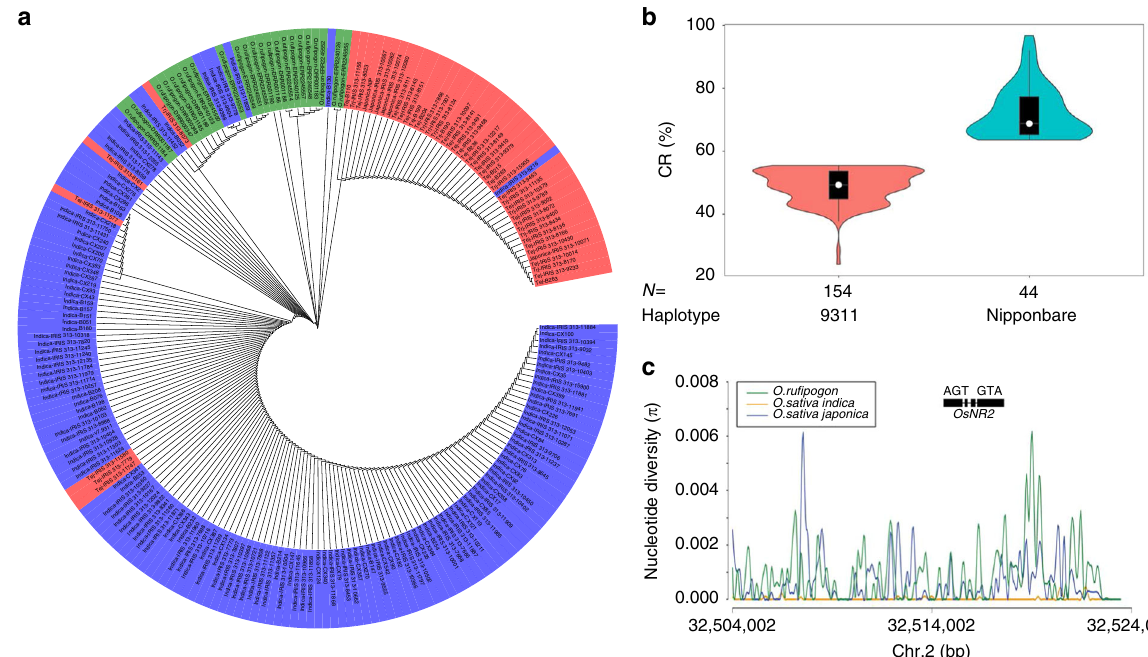
Fig. 3 Phylogenetic and functional analysis of OsNR2 haplotypes. a Phylogenetic tree of OsNR2 CDS from 222 accessions. Blue: O. sativa indica ; red: O. sativa japonica ; green: O. ru fi pogon ; Tej: Temperate japonica ; Trj: Tropical japonica . b Classi fi cation of 199 cultivated rice varieties according to haplotype (9311 versus Nipponbare) and extent of conferred ClO 3 - resistance (CR%). Error bars represent 95% con fi dence intervals. c DNA sequence diversity of the genomic region surrounding OsNR2 in three groups. The green, orange and blue lines indicate site nucleotide diversity ( π ) for O. ru fi pogon , O. sativa indica and O. sativa japonica accessions, respectively. The position of OsNR2 is as indicated (thick lines represent exons and thin lines introns). The source data underlying b are provided as a Source Data fi